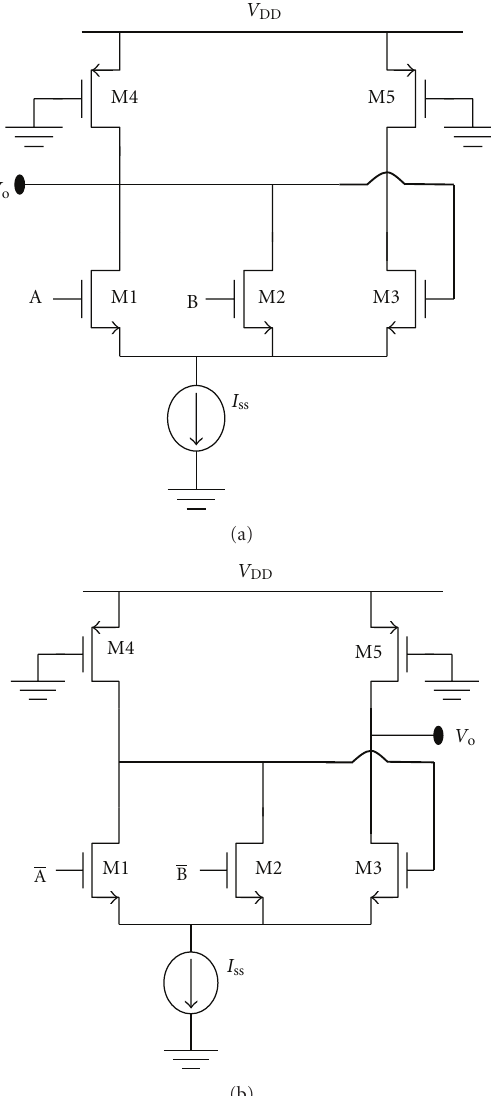
Figure 2: Di ff erent PFSCL gates; (a) 2-input NOR, (b) 2-input